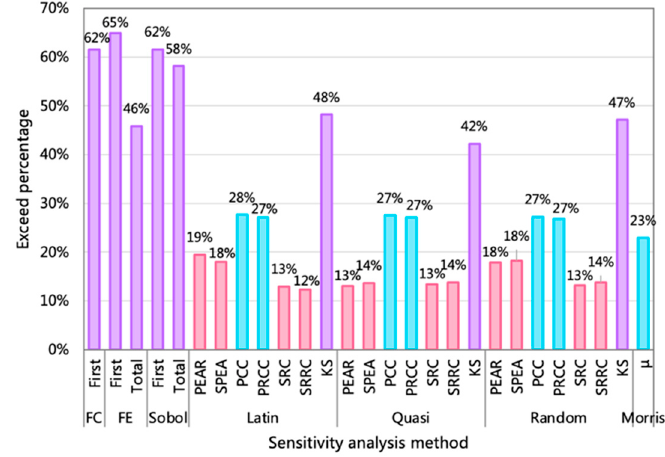
Figure 14. Exceed percentage values in different sampling and SA methods.